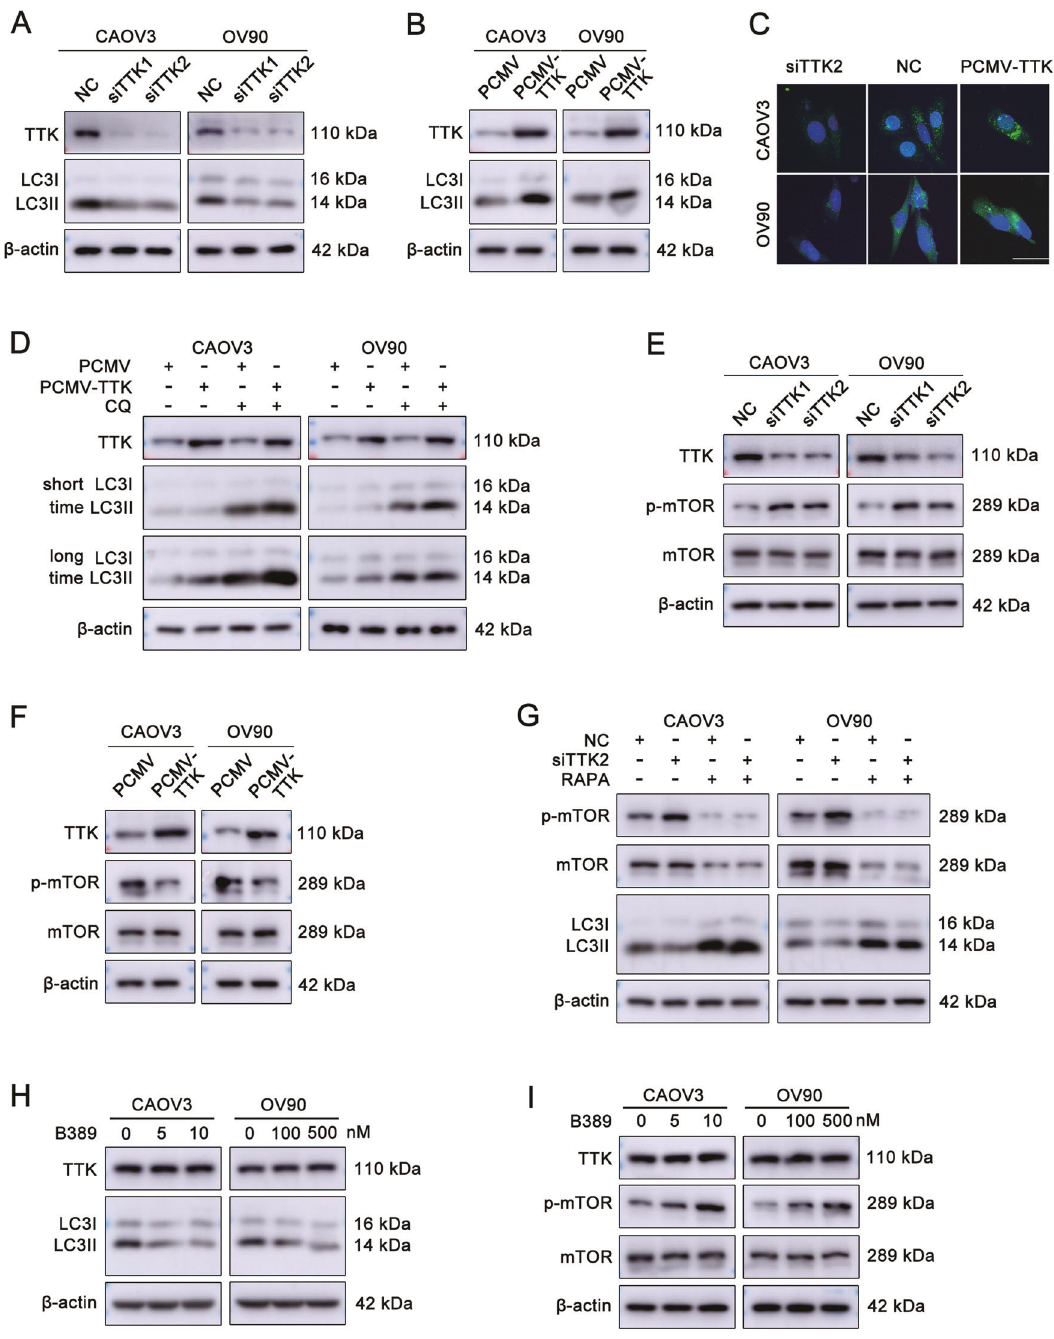
Fig. 6 TTK depletion inhibits autophagy by activating the mTOR signaling pathway in ovarian cancer cells. A CAOV3 and OV90 cells were transiently transfected with NC or siTTK for 48 h. Protein levels of LC3-I, LC3-II, TTK, and β -actin were assessed using western blotting. B Western blot assays were conducted to detect the LC3-I, LC3-II, TTK and β -actin protein levels in CAOV3 and OV90 cells after transfection with PCMV or PCMV-TTK. C Representative images of immuno fl uorescence staining for LC3B in ovarian cancer cells transfected with siTTK, NC, and PCMV-TTK for 48 h (×400). Scale bar: 15 µm. D CAOV3 and OV90 cells transfected with PCMV or PCMV-TTK were treated with or without CQ (50 μ M) for 24 h. Levels of the LC3-I, LC3-II, TTK and β -actin proteins were analyzed using western blotting. E CAOV3 and OV90 cells were transfected with NC or siTTK for 48 h. Levels of the p-mTOR, mTOR, TTK, and β -actin proteins were evaluated using western blotting. F Western blot assays were performed to show the levels of the p-mTOR, mTOR, TTK and β -actin proteins in CAOV3 and OV90 cells transfected with PCMV or PCMV-TTK for 48 h. G CAOV3 and OV90 cells transfected with NC or siTTK were treated with or without 100 nM rapamycin for 24 h. The levels of p-mTOR, mTOR, LC3-I/II, TTK, and β -actin were measured using western blotting. H Levels of the LC3-I, LC3-II, TTK, and β -actin proteins in CAOV3 and OV90 cells treated with B389 for 48 h. I Western blot analysis was performed to detect the levels of the p-mTOR, mTOR, TTK and β -actin proteins in CAOV3 and OV90 cells treated with B389 for 48 h (data are mean ± SEM, n =